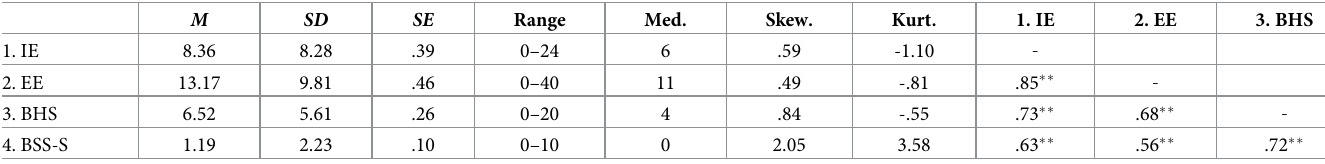
Table 1. Descriptive statistics and Pearson product-moment